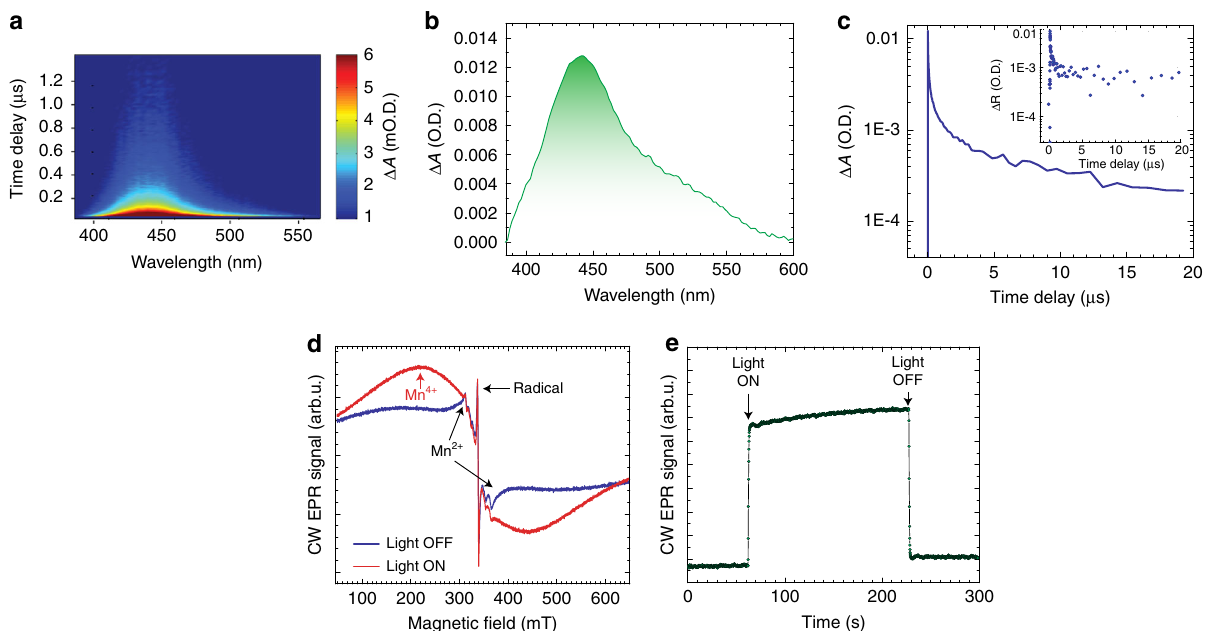
Fig. 3 Probing the light induced processes through transient absorption (TA) and electron paramagnetic resonance (EPR) measurements. a A TA map, b spectrum at 0.026 µ s pump-probe time delay, and c dynamics at 448 nm for an LMO fi lm using 3.2 eV (390 nm) pump photons. Inset shows transient diffuse scattering experiments performed on a fully operational LMO composite cathode. d Continuous wave (CW) X-band EPR spectra of a charged LMO battery cathode in the ‘ light-off ’ state (i.e., before illumination shown in blue spectrum) and ‘ light-on ’ state (i.e., during illumination in red spectrum) with white light. T = 10 K. The CW EPR results in a derivative-type lineshape. e, Time dependence of the EPR signal at 210 mT before, during ( ‘ light-on ’ ), and after illumination ( ‘ light-off ’